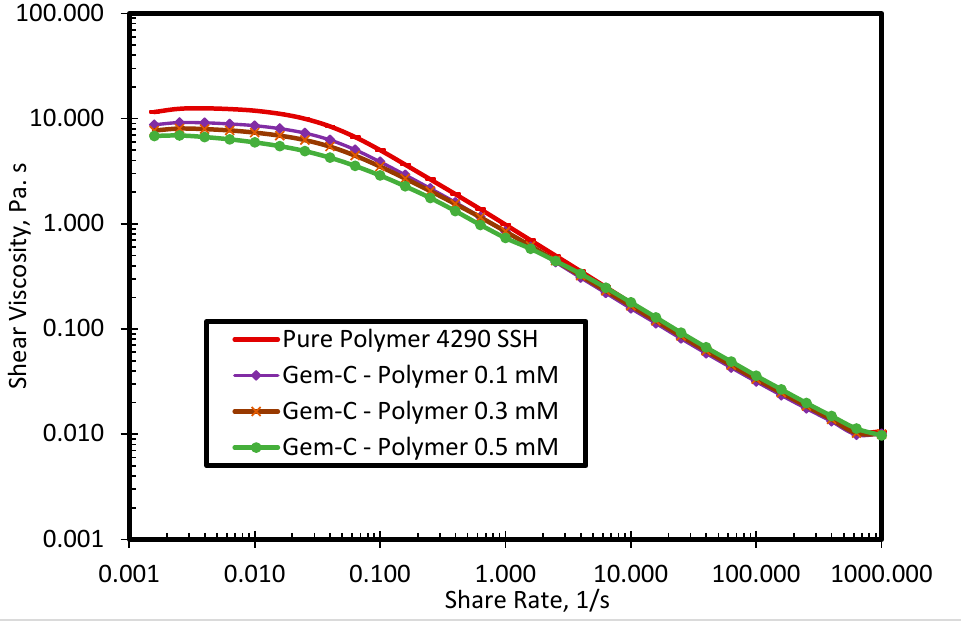
Figure 6. Shear viscosity of 4290 SSH polymer with Gem-C surfactant at different concentrations.